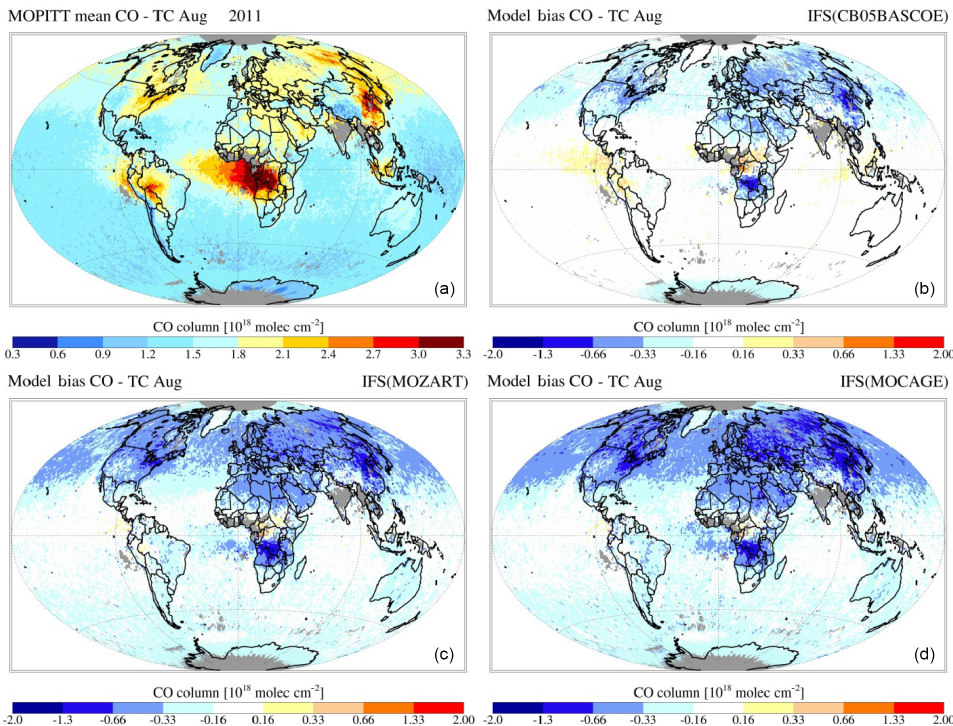
Figure 9. MOPITT CO total column retrieval for August 2011 (a) and simulated by IFS(CBA) (b) , IFS(MOZ) (c) and IFS(MOC) (d)